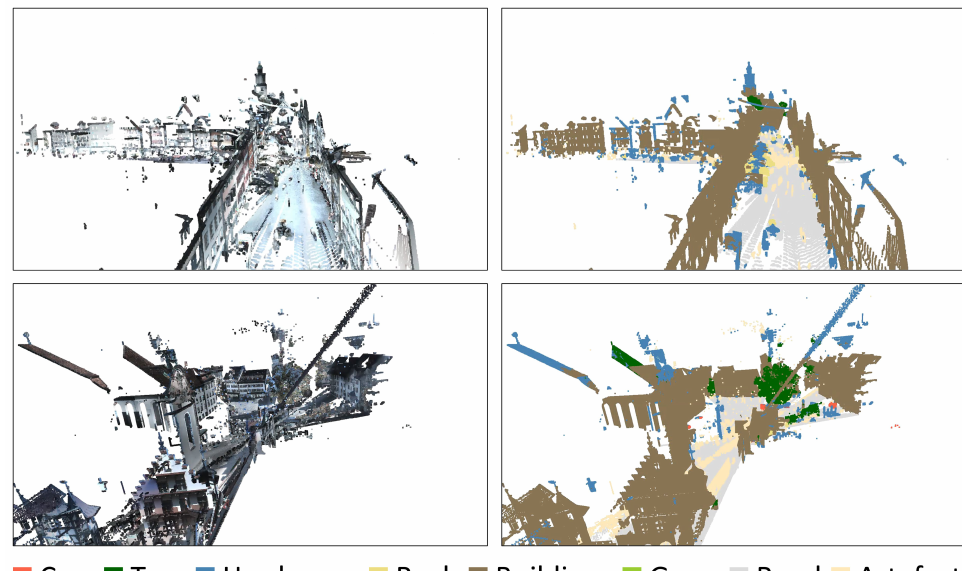
Figure 5. Visualization of partial prediction results of Semantic3D (reduced-8). Left : Raw RGB images of the input point clouds. Right : Visualization of inference results of testing set by MFFRand. Top : Scenario of MarketplaceFeldkirch_station4. Bottom : Scenario of StGallenCathedral_station6.